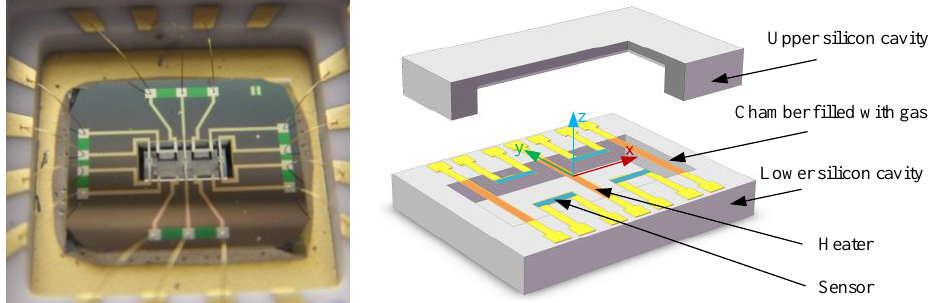
Figure 11. A thermal gas inertial sensor based on thermal expansion.